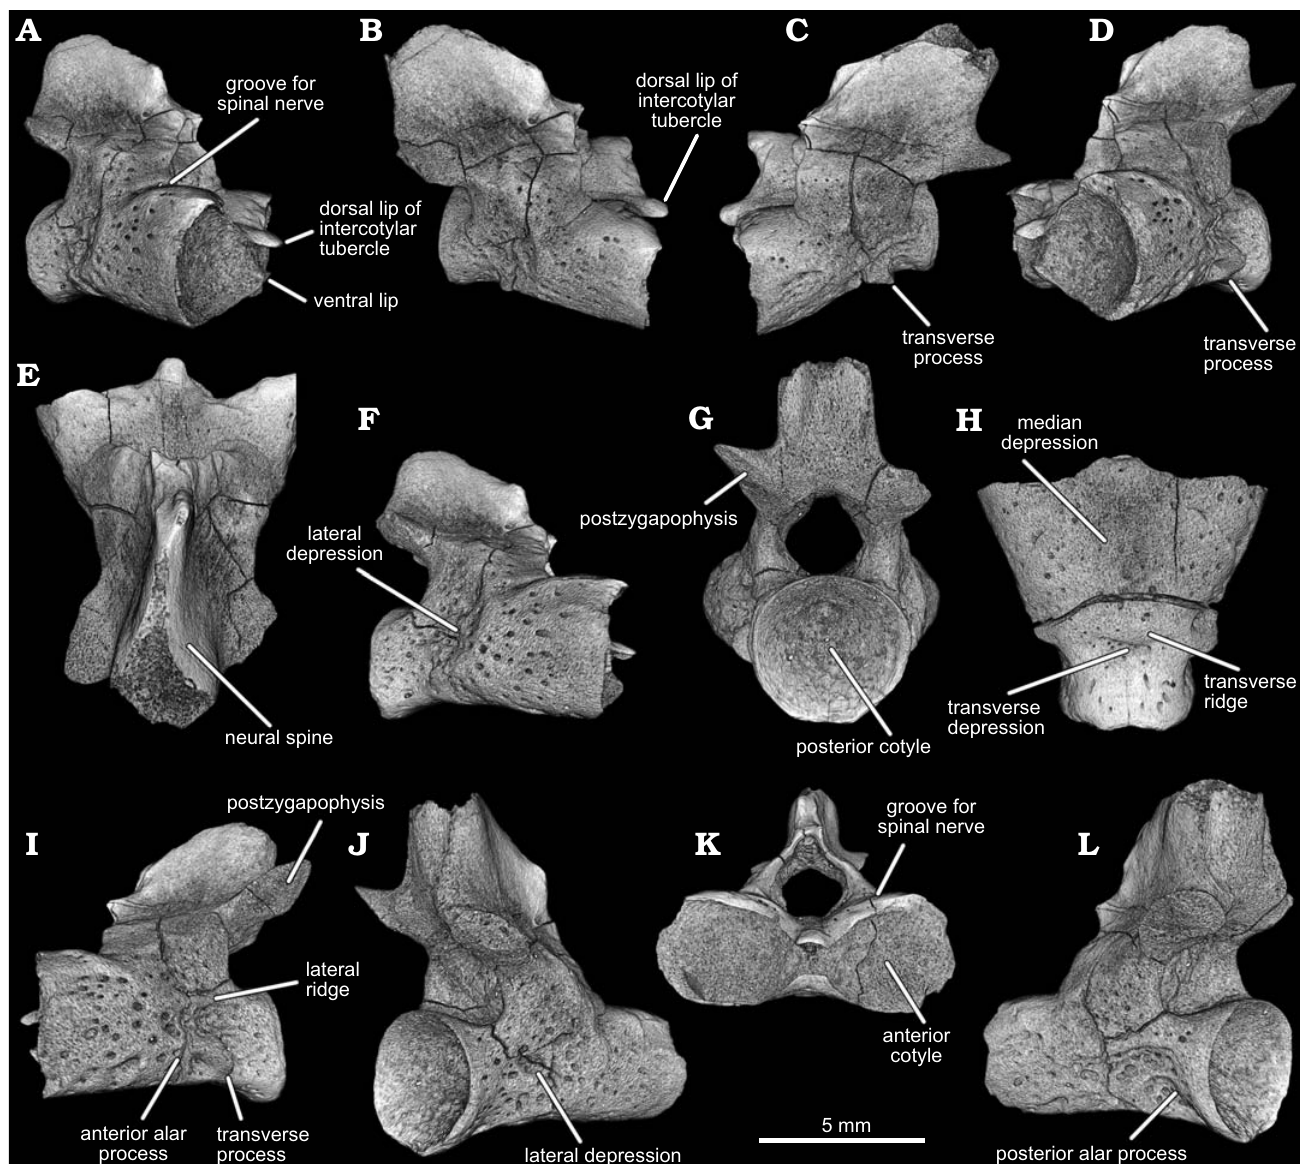
Fig. 3. Stem salamander Kulgeriherpeton ultimum gen. et sp. nov. from Teete locality, Yakutia, Eastern Siberia, Russia; Sangar Series, Batylykh Formation, Berriasian–Barremian, Lower Cretaceous. Digital restoration of atlas ZIN PH 3/246 (holotype) in right antero-lateral ( A ), right dorso-lateral ( B ), left dor- so-lateral ( C ), left antero-lateral ( D ), dorsal ( E ), right lateral ( F ) posterior ( G ), ventral ( H ), left lateral ( I ), right postero-lateral ( J ), anterior ( K ), and left postero-lateral ( L )